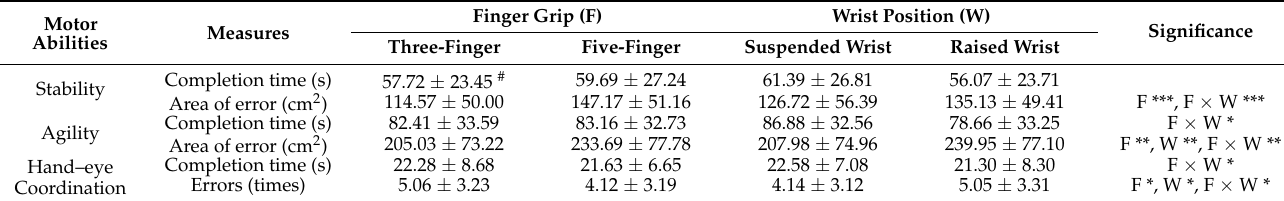
Table 1. Two-way ANOVA results of the finger grip and the wrist position on Chinese calligraphic handwriting perfor- mances. Motor Measures Abilities Stability